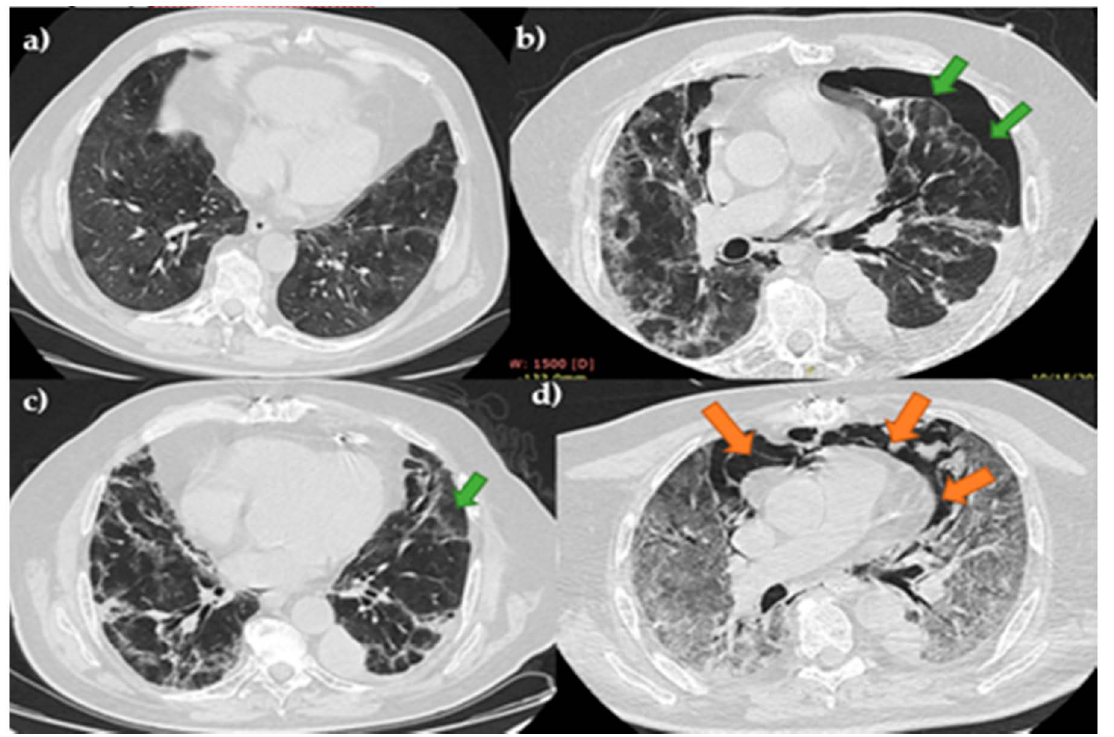
Figure 1. Case 1–patient admitted with moderate COVID-19 injury, developed PT and subsequently PM. Legend: PT- pneumothorax—green arrow; PM-pneumomediastinum—orange arrow; ( a ) initial CT with moderate injury; ( b ) right PT; ( c ) control CT after surgical drainage of PT; ( d ) PM and severe pulmonary